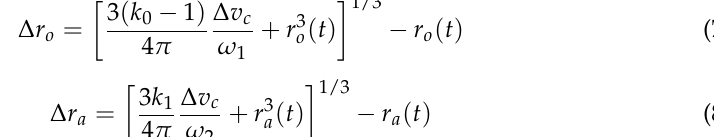
Figure 3. Interference between cement particles: ( a ) from air, ( b ) from hydration product gel, and ( c ) from unhydrated cement particle.